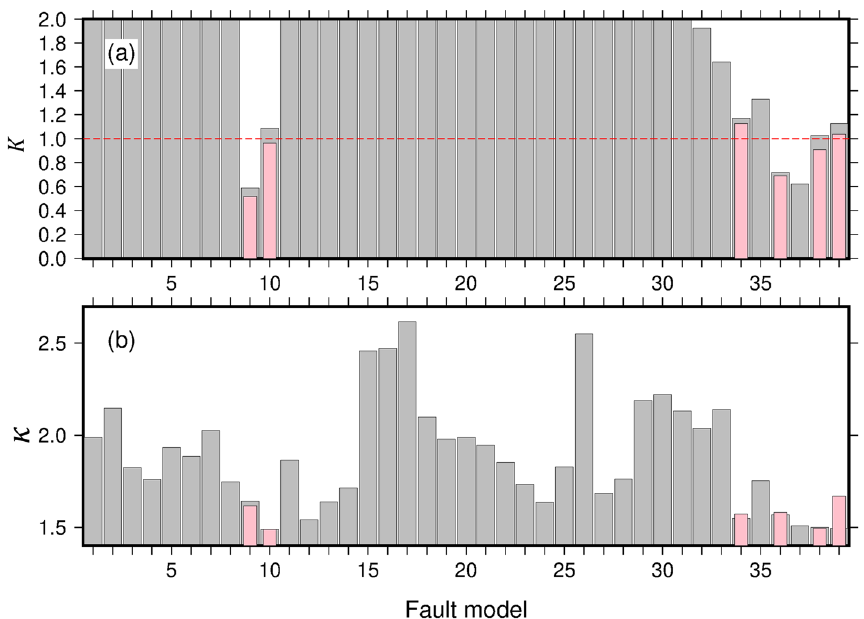
Figure 4. Histograms for ( a ) K and ( b ) κ for all fault models obtained with the non-dispersive and dispersive equations (gray and pink bars, respectively). The dashed red line indicates K = 1, representing a good match between the observations and predictions. The dispersive model was calculated only for fault models 9, 10, 34, 36, 38, and 39 because of computational resource limitations.